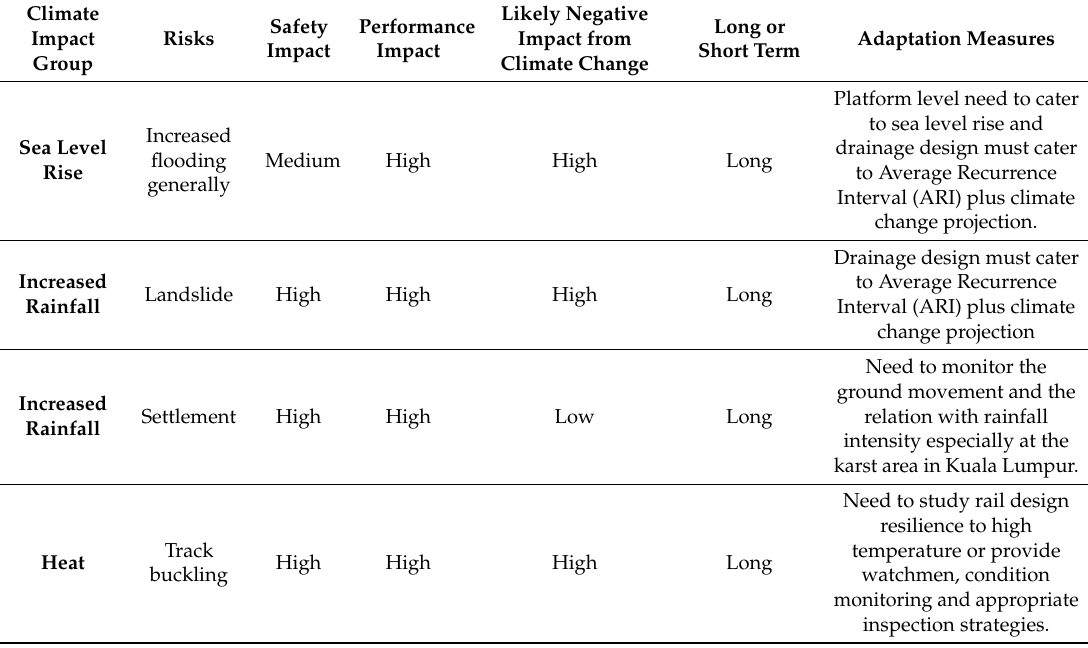
Table 3. Risks and adaptation measures for high speed rail in